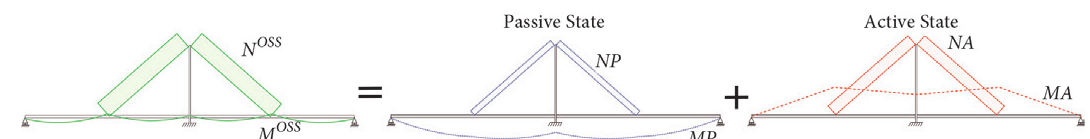
Fig. 1. Bending moment diagrames and stay forces at